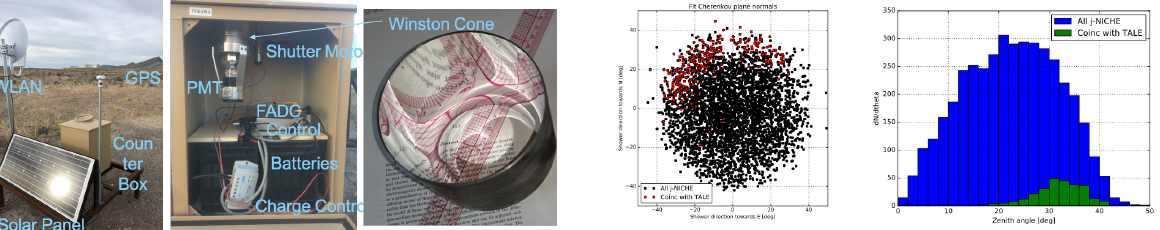
Figure 3. Left: The arrival direction of showers reconstructed from a plane fit to the Cherenkov wave front. Those events which are coincident with TALE events are shown in red. Right: The zenith angle distribution of NICHE plane fit events. Those events coincident with TALE are shown in green.